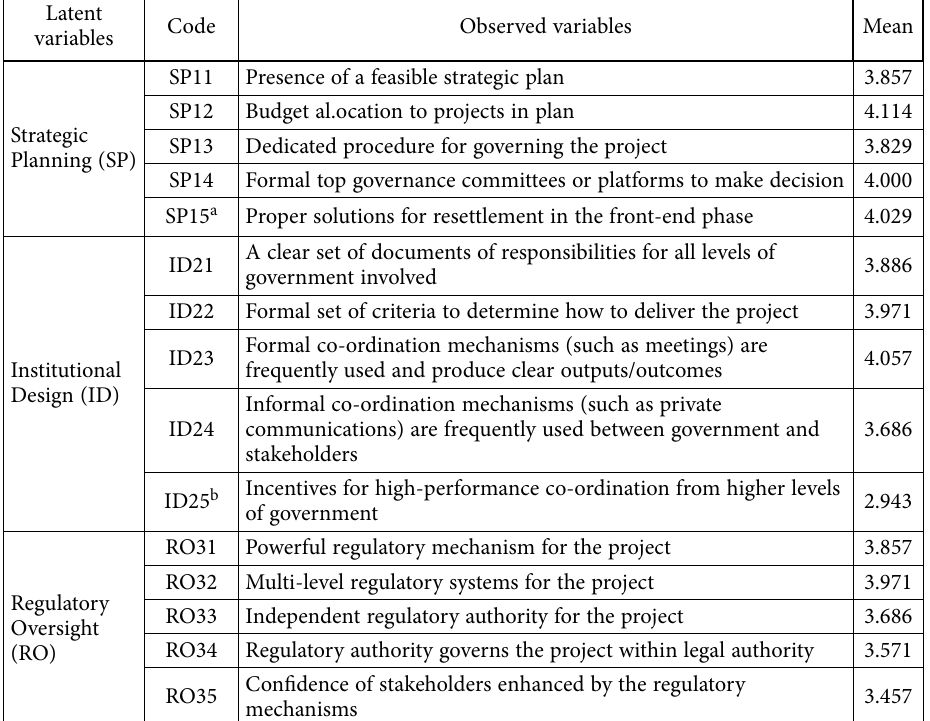
Table 6. Observed variables of governmental governance and megaproject